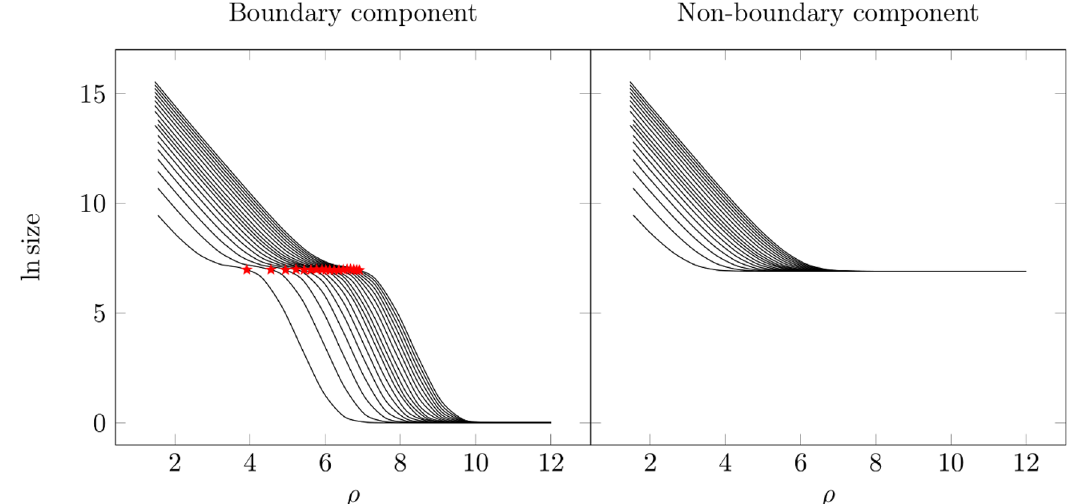
Figure 8. Size at (cid:12)xed t R = 0 for various (cid:12) to the right. We have indicated the intersection of the vertical line ln (cid:12) curve by a